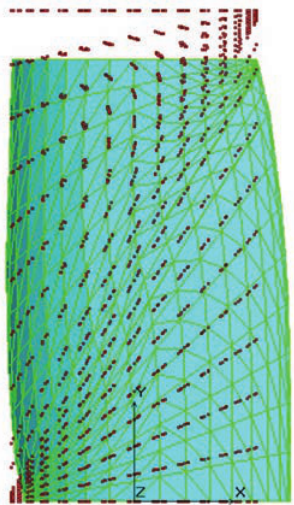
Fig. 12. Deformed shape of sample of triaxial test with fixed ends